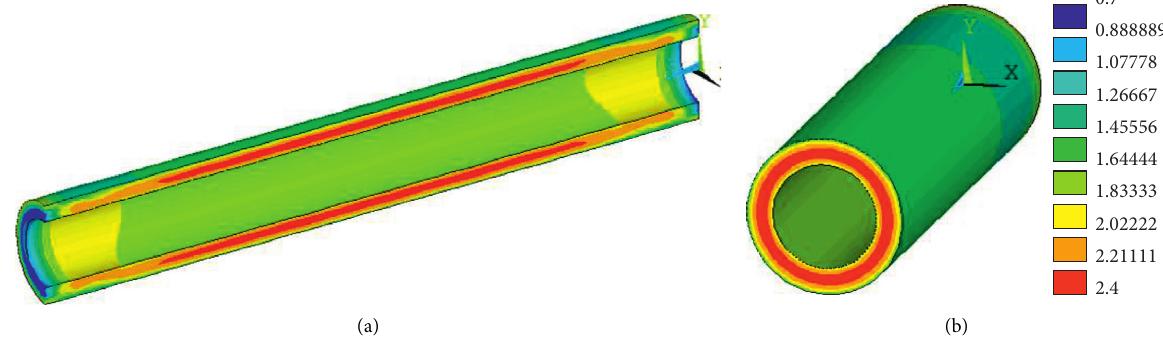
Figure 11: Stress envelope diagram of tunnel model for IC along and vertical to flow direction (MPa).